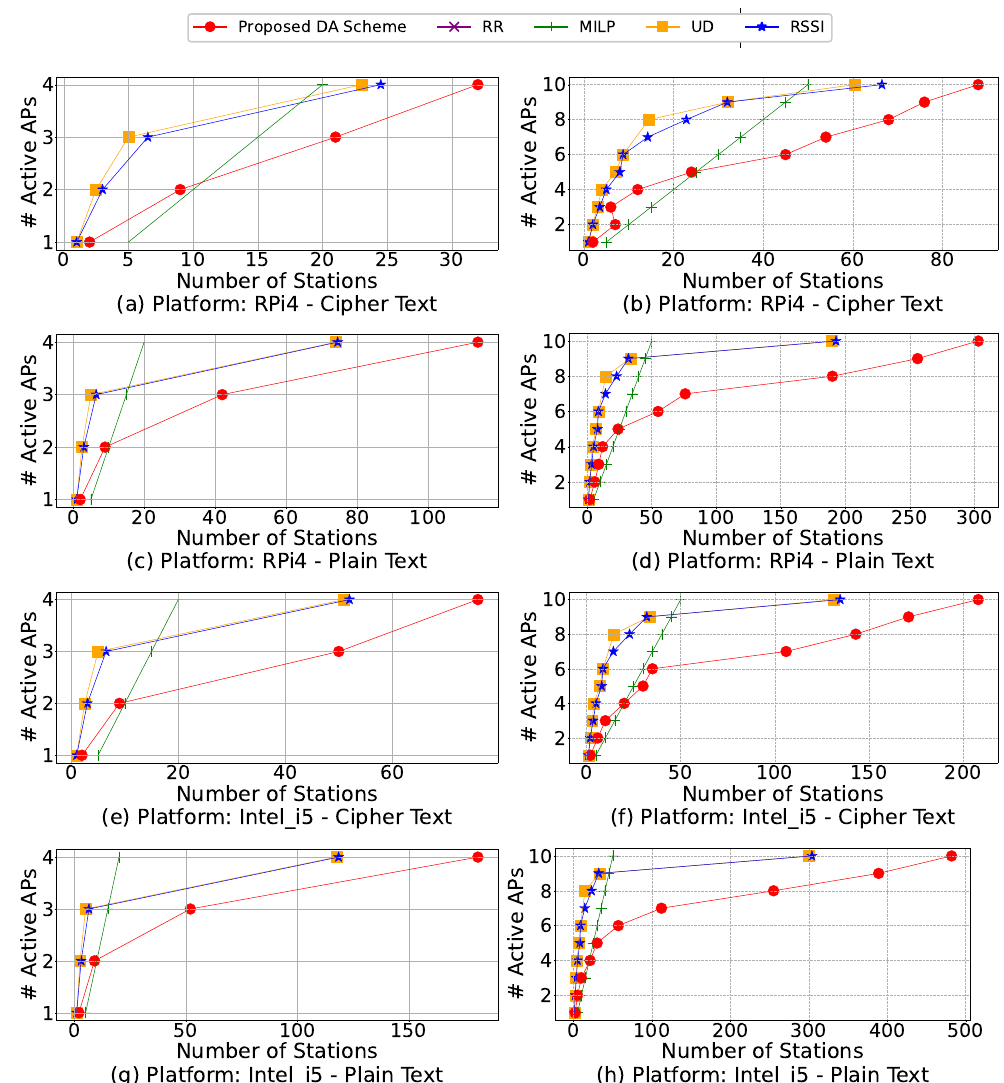
Figure 11. Number of active APs required by a fixed amount of network throughput. Four algorithms are implemented on RPi4 and Intel_i5 platforms across two scenarios: cipher text and plain text. The number of active APs could be lower than the total number of APs available, as some algorithms do not need all APs to be able to support a particular number of